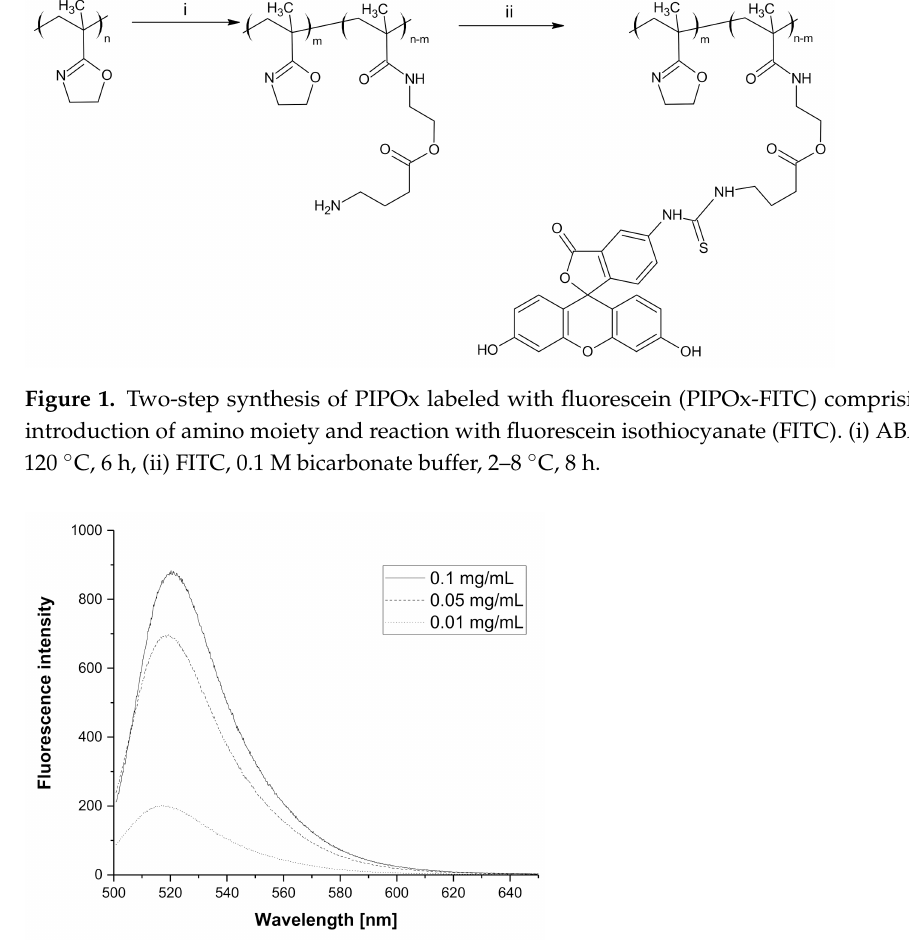
Figure 2. Emission spectra of PIPOx-FITC measured in methanol in three concentrations (0.1 mg/mL, 0.05 mg/mL and 0.01